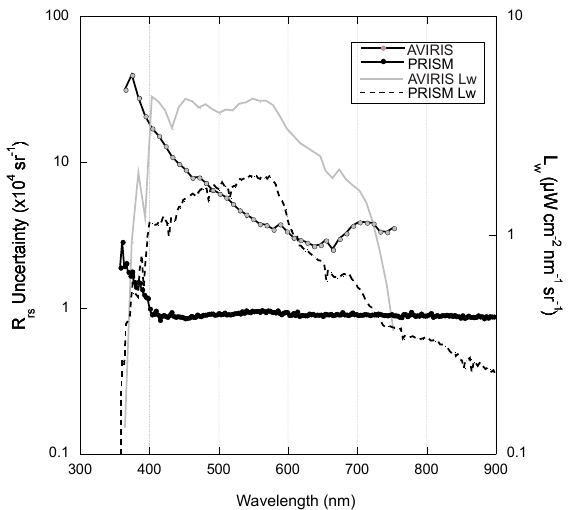
Figure 6. Comparison of AVIRIS (Grizzly Bay; dark grey) and PRISM (Elkhorn Slough; black) R rs uncertainty, with the corresponding water-leaving radiance (L w ) values for each region (dashed black: PRISM; light grey: Grizzly Bay). Missing data below ~350 nm and above ~750 nm were caused by negative radiances after atmospheric correction.